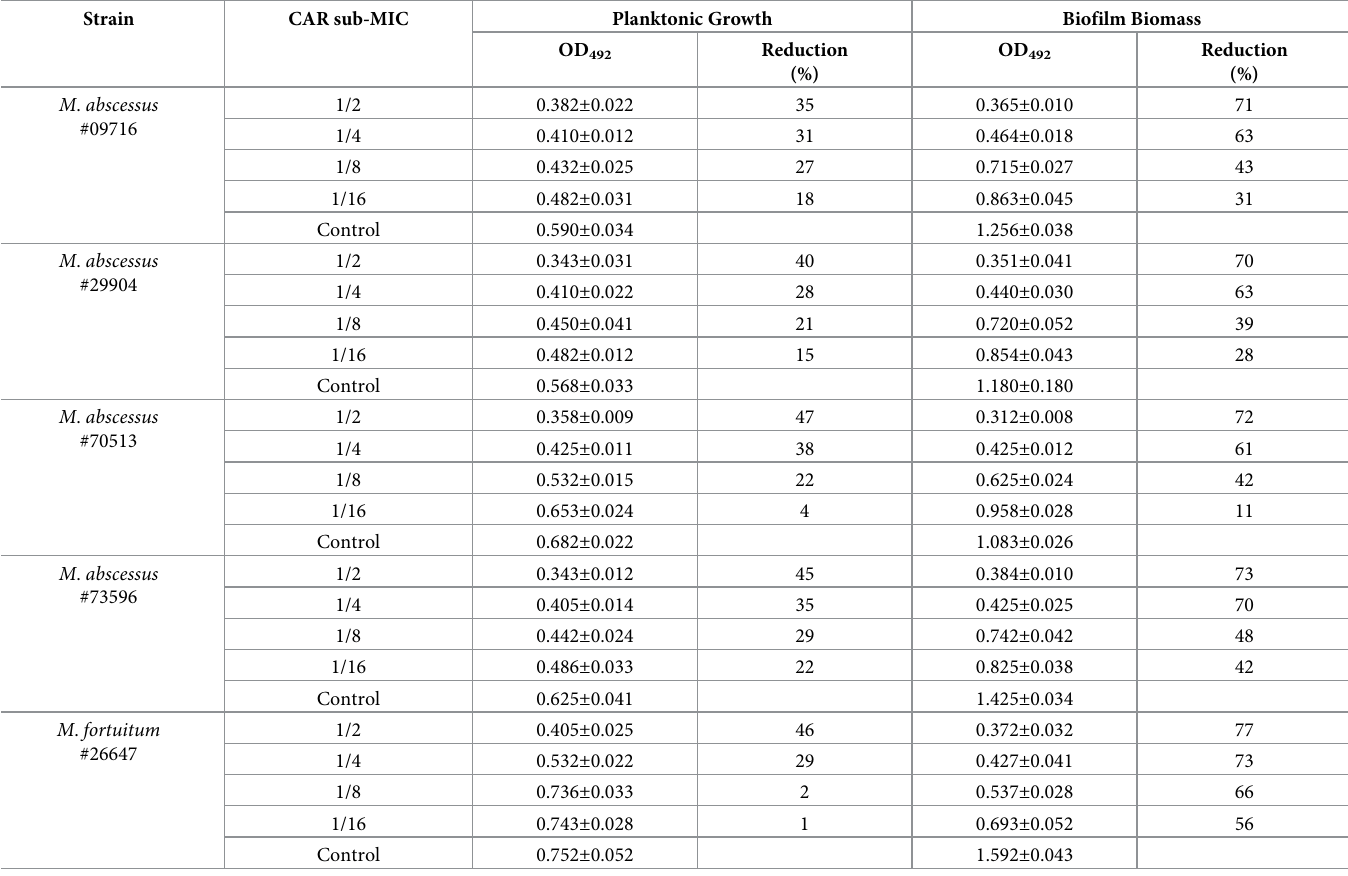
Table 3. Effect of CAR at sub-MICs on planktonic growth and biofilm formation.